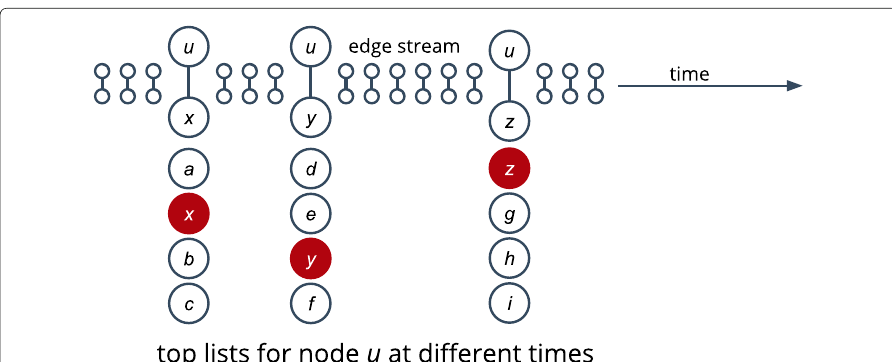
Fig. 14 The online link prediction problem. For each edge in the stream, first we query the model to